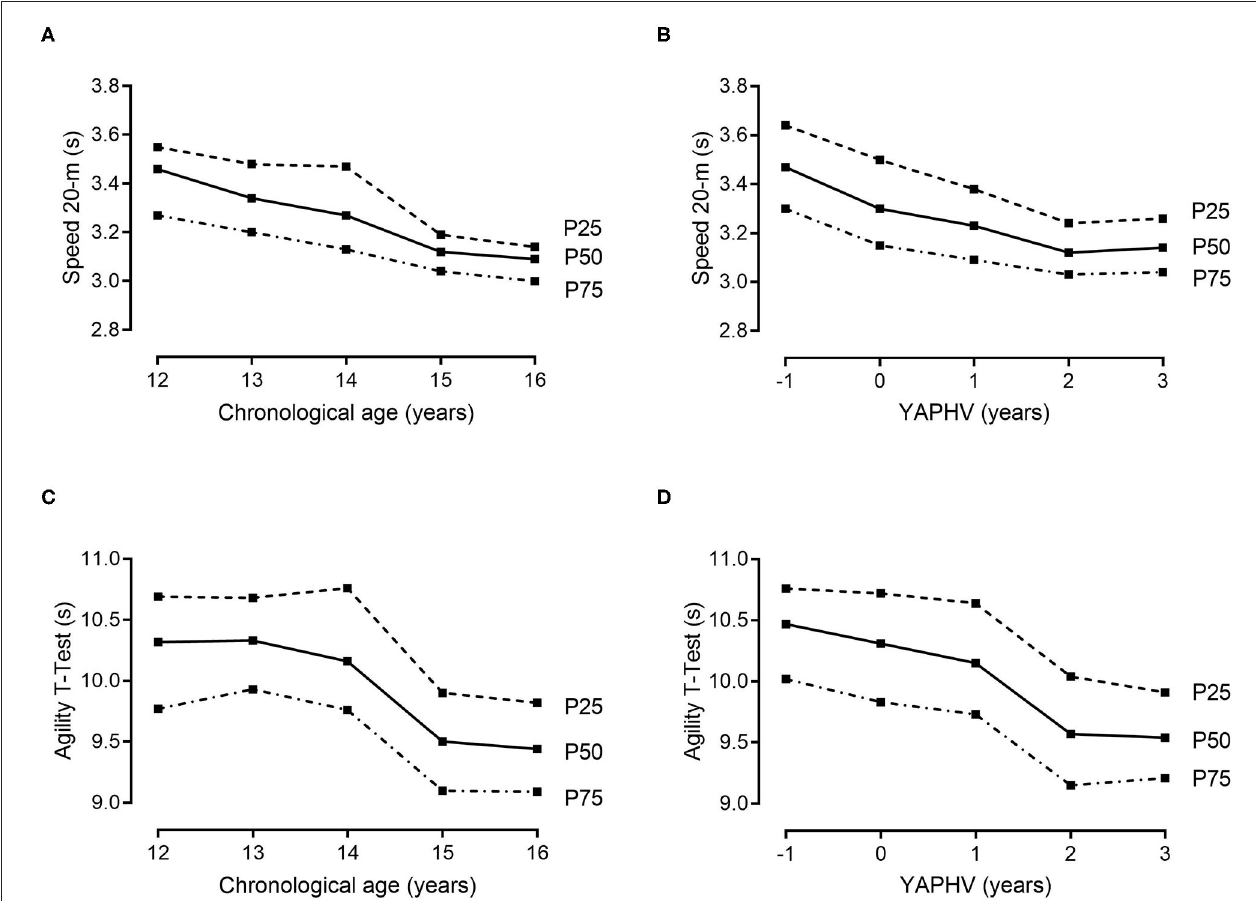
FIGURE 4 | References values (10th, 25th, 50th, 75th and 90th percentiles) for MBT and HG strength of young Portuguese male basketball players, according to their chronological age and maturity status.